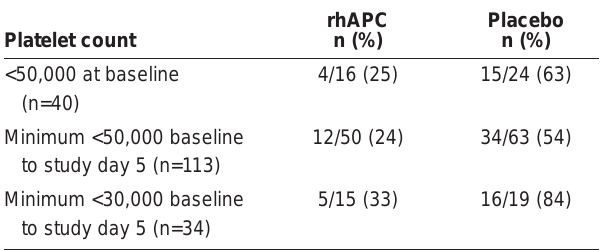
TABLE 5 Incidence of serious adverse events in the PROWESS